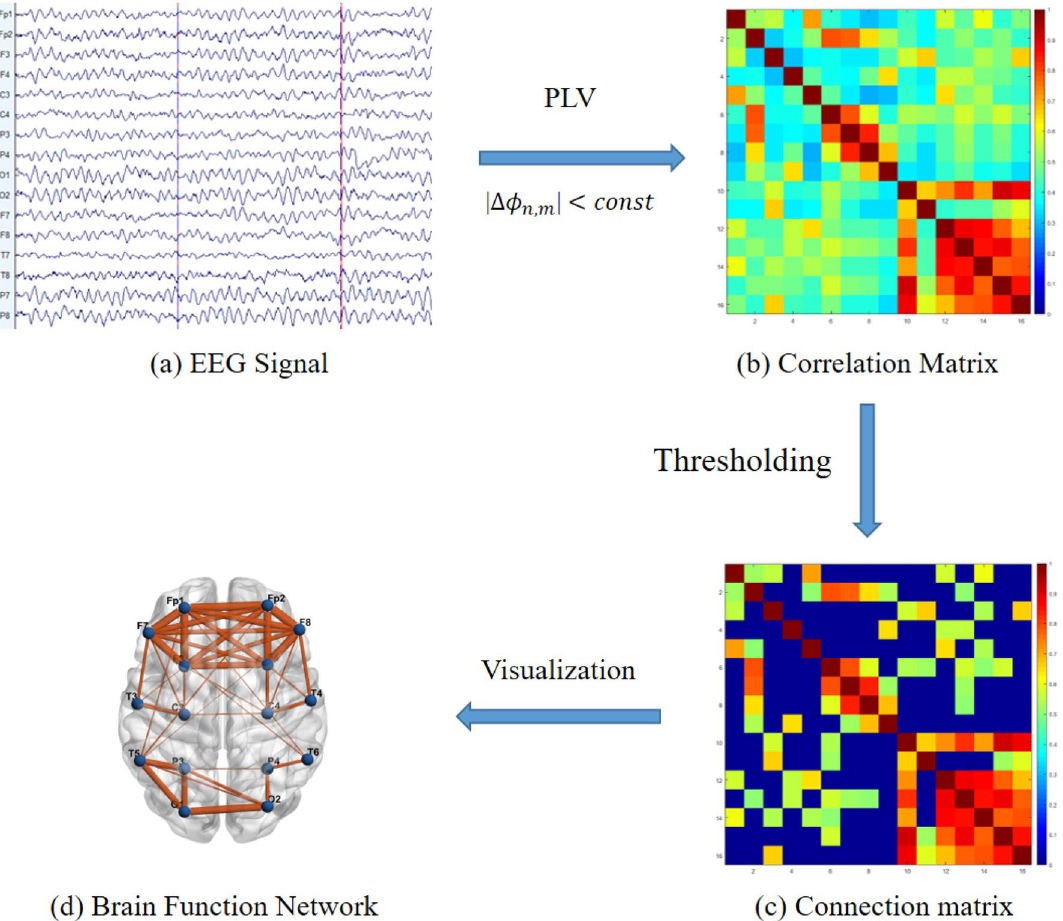
Figure 1. Flow chart of the brain network construction of the EEG signal. EEG electroencephalogram, PLV phase locking value. Figure ( a ) was generated by an EEG processing tool of “EEGLAB” (Version 2019.0, https:// sccn. ucsd. edu/ eeglab/ index. php), based on MATLAB (Version R2018a). Figure ( b – d ) were generated by a brain network visualization tool of "BrainNet Viewer" (Version1.62, https:// www. nitrc. org/ proje cts/ bnv/), based on MATLAB (Version